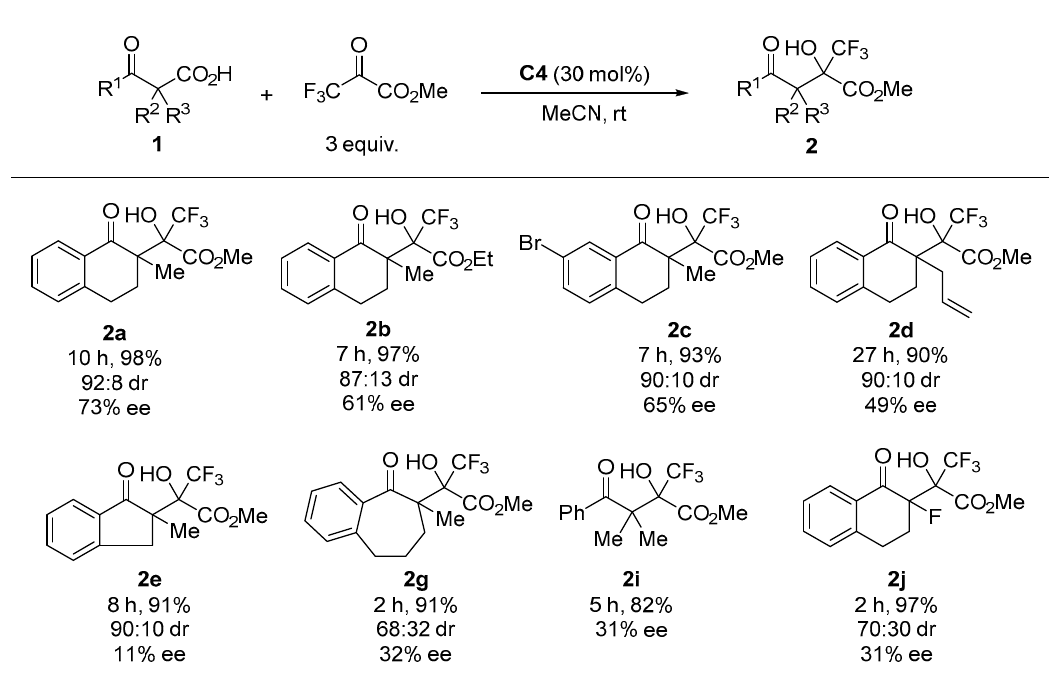
Figure 3. Enantioselective decarboxylative aldol reaction of 1 1 . 1 All reactions were carried out at room temperature in acetonitrile with 3 equiv. of trifluoropyruvates in the presence of 30 mol% C4. Isolated yields were described. Diastereomeric ratios were determined by 1 H-NMR analyses. Enantiomeric excess was determined by chiral HPLC analysis.